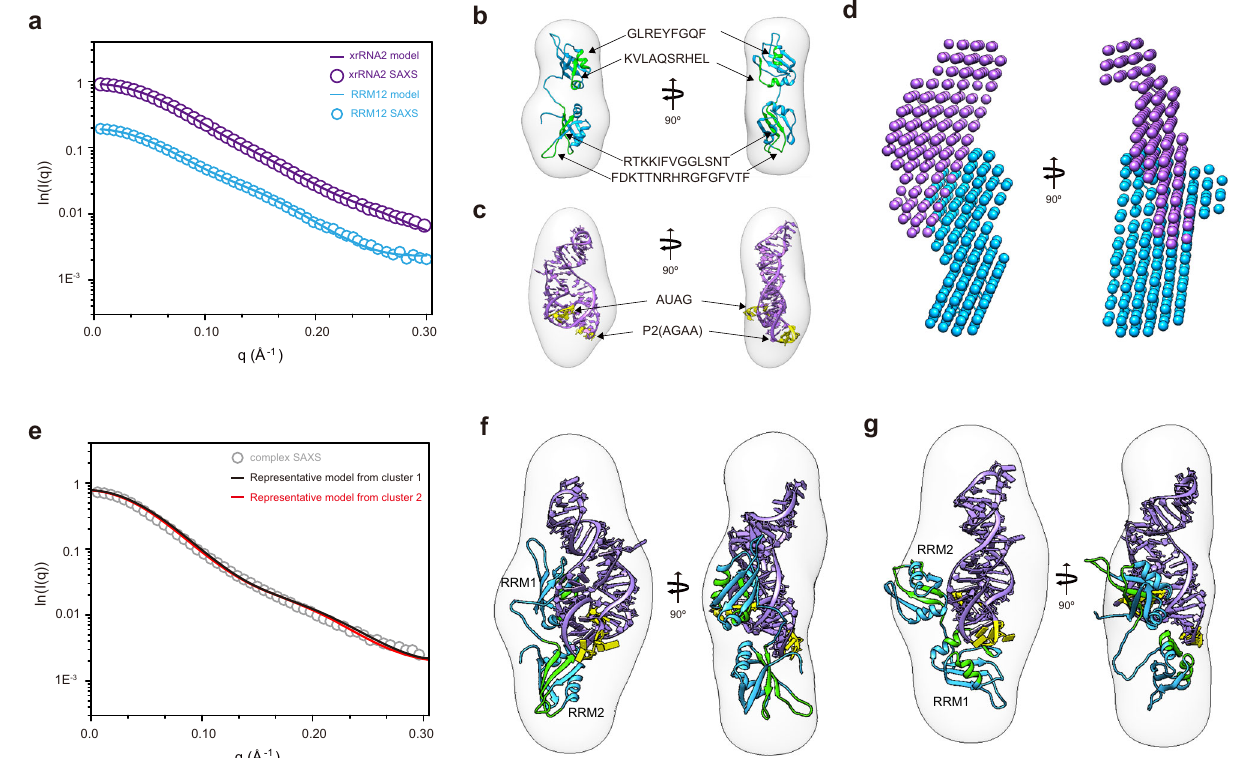
Fig. 7 | Structural investigation of the MSI1 RRM12-xrRNA2 complex by inte- grative methods. a Structural characterization of free RRM12 and free xrRNA2 by SAXS. The back-calculated scattering pro fi les (solid line) of the best models were overlaid with the respective experimental pro fi les (open cycle). b The homology modelofRRM12(blue)wasfurthersubjectedtorigidbodyre fi nementagainstSAXS data by Xplor-NIH and fi tted into the envelope ab initio. The residues presumably involved in xrRNA2 binding identi fi ed by HDX-MS are highlighted in green. c The besthomologymodelofxrRNA2(purple)was fi ttedintotheenvelopeabinitio.The pMBS1 and AGAA tetraloop of xrRNA2 are highlighted in yellow. d The 3D shape